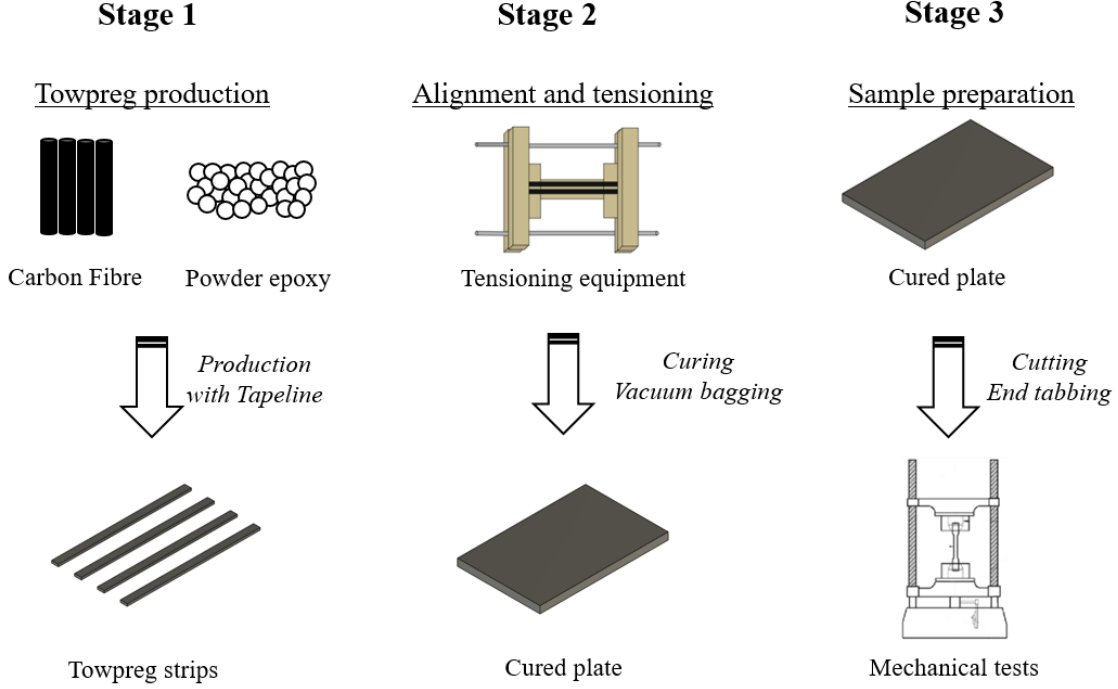
Figure 2. Different stages of the UD composite plate